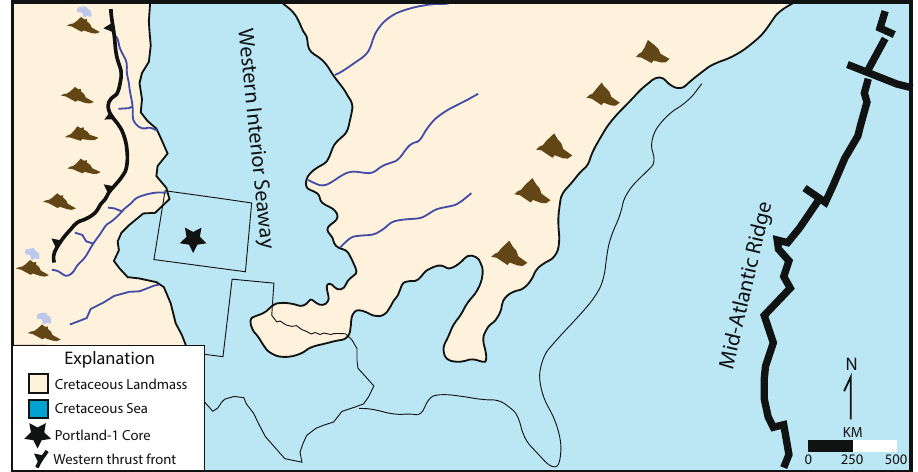
Figure 1. Paleogeographic map of North America during Oceanic Anoxic Event 2. The location of the Portland-1 core as well as active volcanic centers are shown. Map was drawn in Adobe Illustrator version 25.2.3 (www. adobe. com) from information presented in Caron et al. and Robinson Roberts and Kirschbaum 22,23